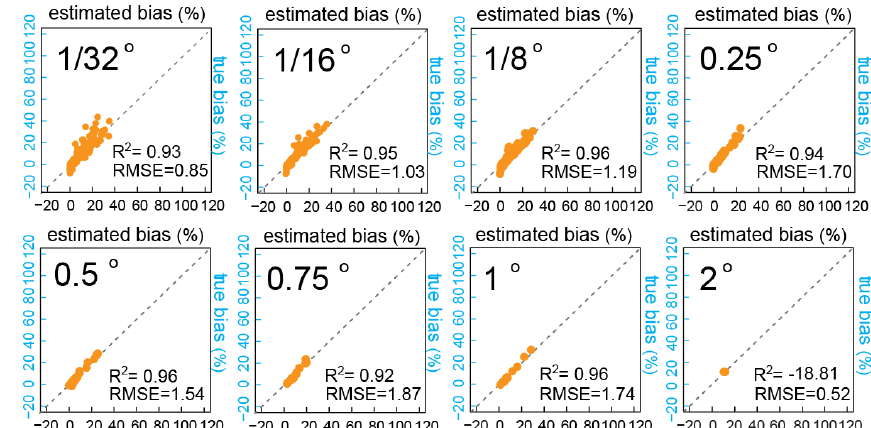
Figure 3. Daily estimated aggregation bias in ET estimates (%, median of daily biases in April–October 2004) versus daily true aggregation bias in ET estimates (%, median of daily biases in April–October 2004) at several spatial scales. Estimated aggregation biases are calculated using Eq. (7). True aggregation biases are calculated as differences between the finer-resolution ET estimates from finer-resolution input data, averaged over several spatial scales (average of functions) and ET values calculated from average inputs at each spatial scale (function of averages). The coefficients of determination ( R 2 ) between the true and estimated aggregation biases verify the reliability of the Taylor expansion method and Eq. (7) as estimates of the aggregation